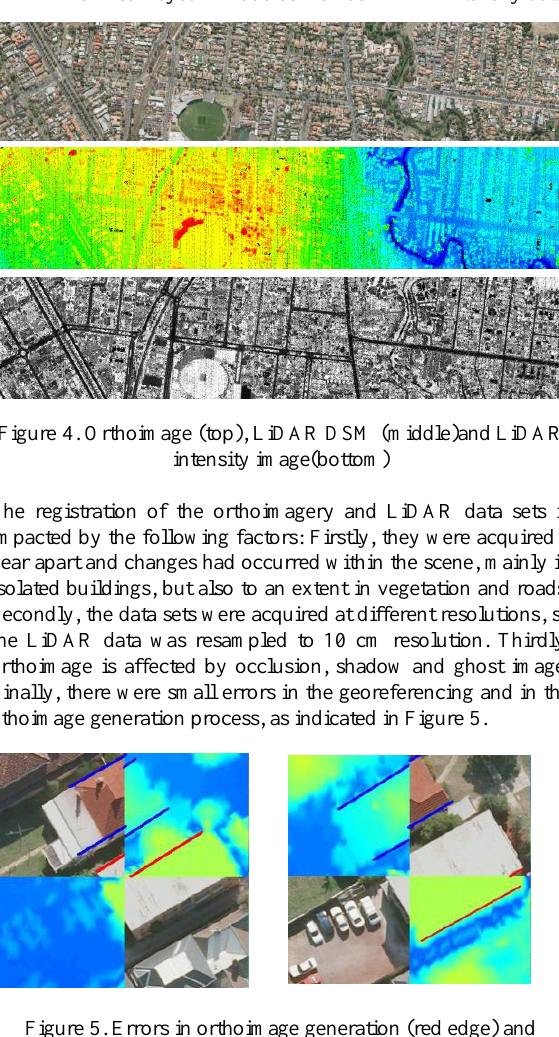
Figure 5. Errors in orthoimage generation (red edge) and georeferencing (blue edge)